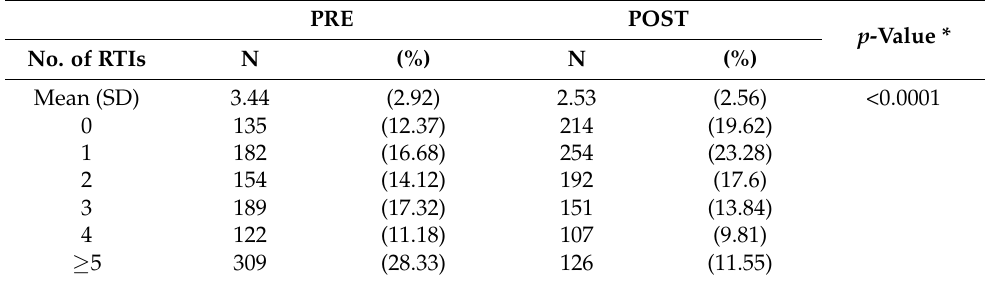
Table 4. RTI frequency in 1091 children included in the PRE and POST period. Pedianet,